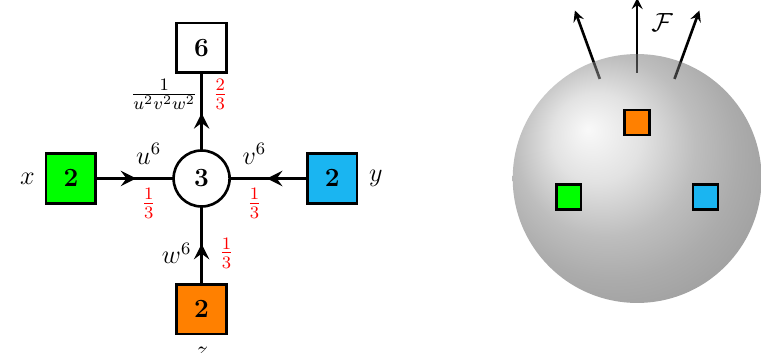
Figure 4: The 4d theory obtained by compactifying the rank one E-string on a three punctured sphere with a particular choice of flux (breaking the E × U ( 1 ) ) and definition of punctures. We will refer to this theory as the down to E 7 A trinion theory, and it is given by SU ( 3 ) SQCD with N 1